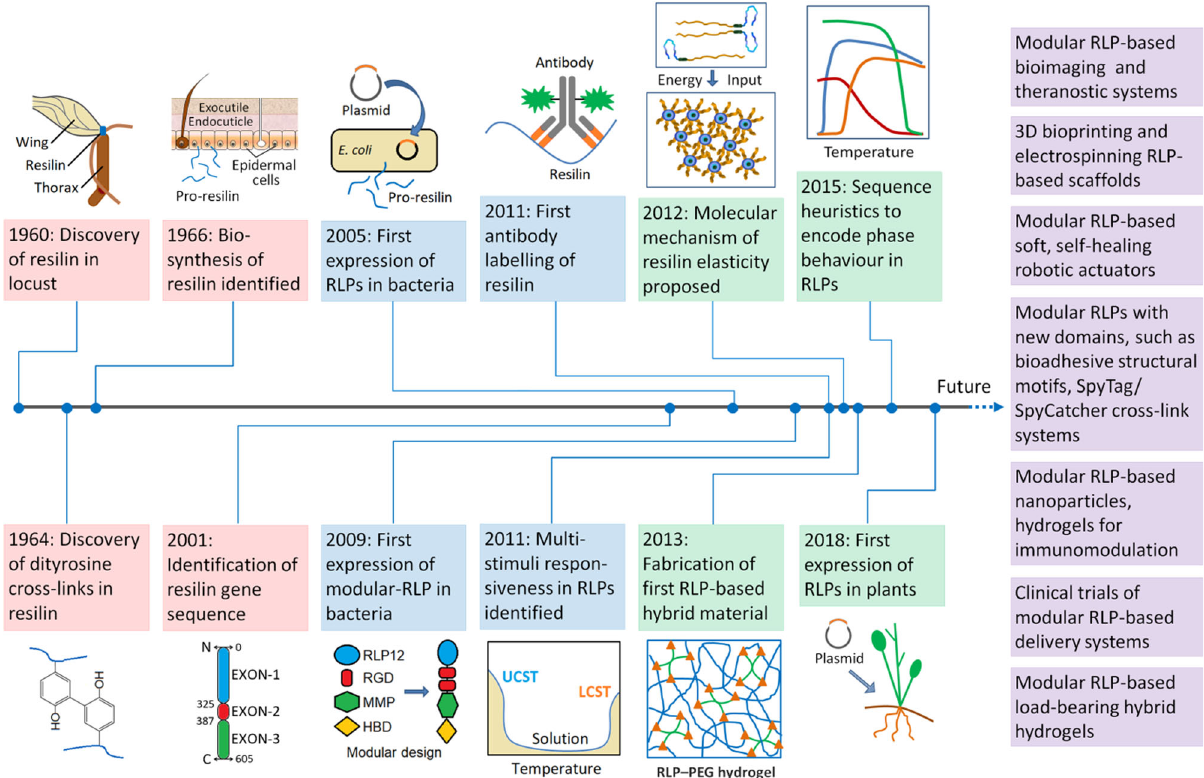
Fig. 1 Timeline of key discoveries and milestones of resilin and RLP-based biomaterials. Description of illustrations (in the order of year): 1960 — locust- wing hinge showing resilin, 1964 — covalent dityrosine crosslinks in native resilin, 1966 — native uncrosslinked pro-resilin synthesized by epidermal cells into the subcuticular space, 2001 — full-length resilin (fruit fl y) showing the three exon regions with respective sequence length, 2005 — RLPs synthesis by recombinant technology, 2009 — domain selection and design of modular RLP, 2011 (top) — RLP (antigen) and RLP-antibody interaction for bioimaging, 2011 (bottom) — plot (temperature versus hydrodynamic diameter) showing both upper critical solution temperature (UCST) and lower critical solution temperature (LCST), dual-phase behaviour of RLPs, 2012 — structural conformation of full-length resilin to stress, 2013 — crosslinked network between RLPs (blue) and four-arm polyethylene glycol (PEG; green) hybrid hydrogel, 2015 — plot (temperature versus ultra-violet absorbance) showing soluble to insoluble transition of RLPs in aqueous solution and 2018 — resilin gene expression in